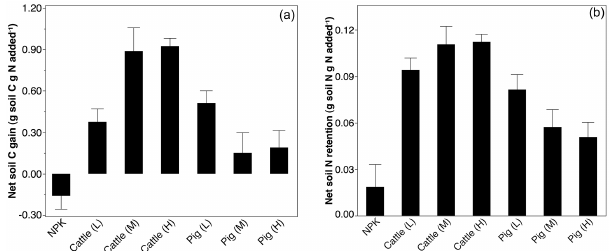
Figure 4. Relationships between (a) net soil C gain (i.e. grams of C gained in the soil) and (b) net soil N retention (i.e. grams of N retained in the soil) per gram of N added over 43 years under each nutrient treatment. Abbreviations as in Fig. 1. Standard errors indi- cate variation among six replicate values for each